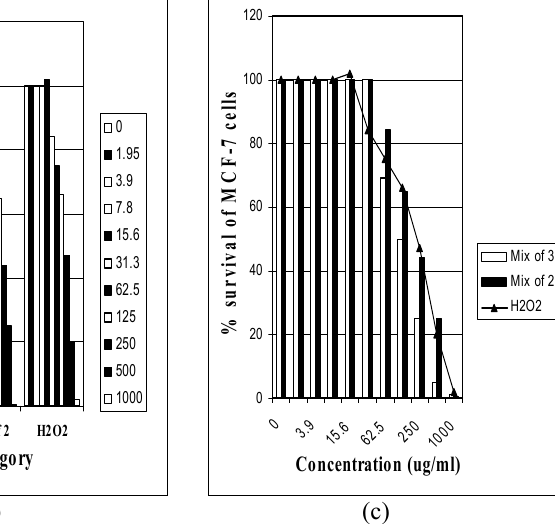
O ), (b) alcohol extract of black seed and hydrogen peroxide (AE + H 2 2